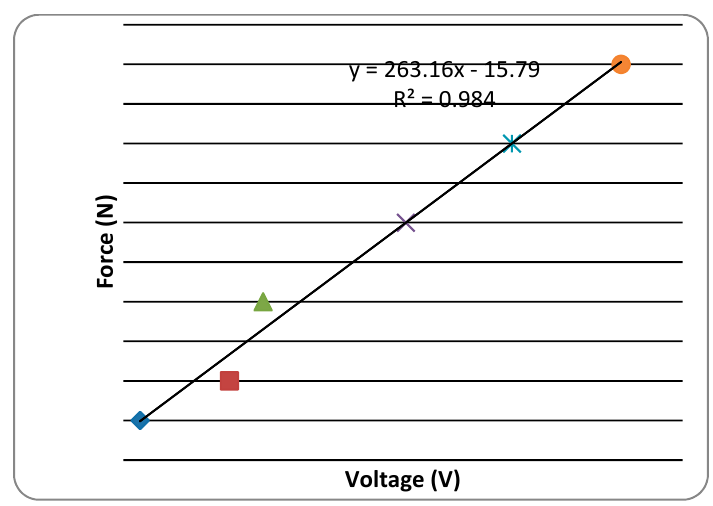
Figure 6. Calibration of force against horizontal voltage.